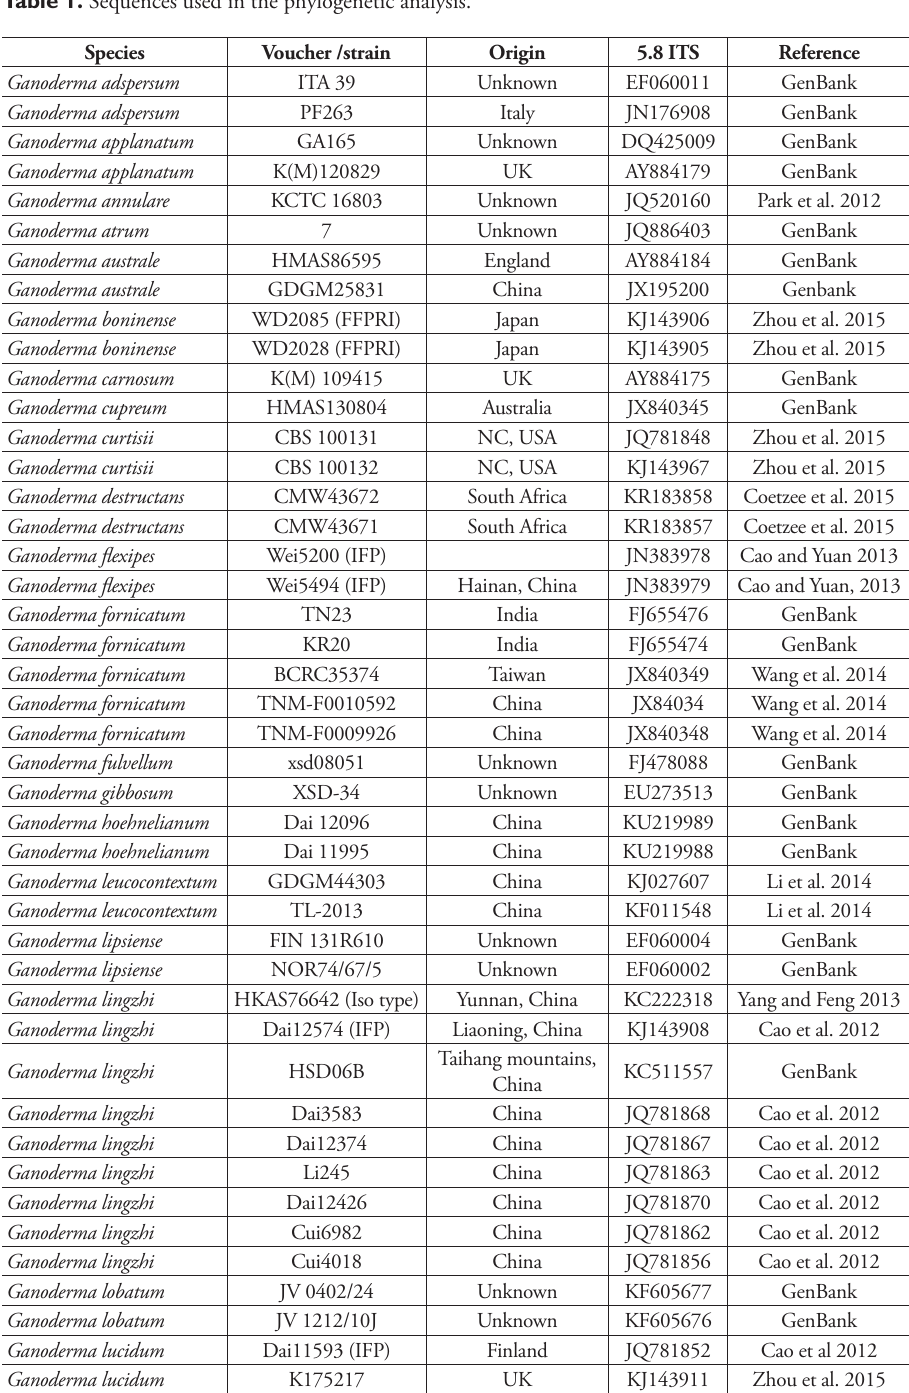
Table 1. Sequences used in the phylogenetic